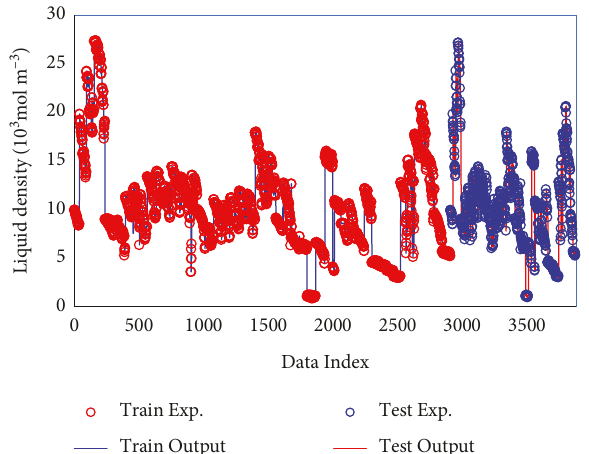
Figure 2: Estimated density values compared to experimental data using the LSSVM